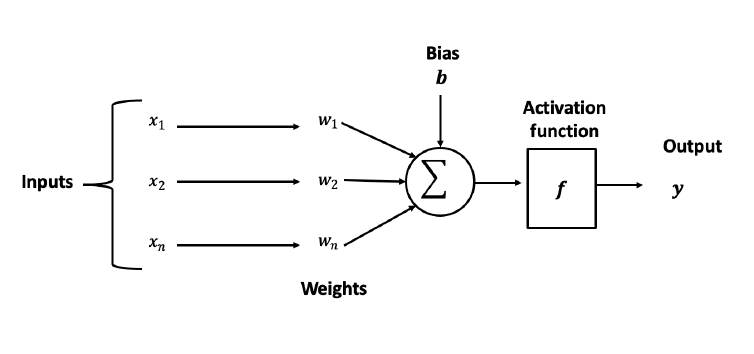
Figure 3. The basic components of an